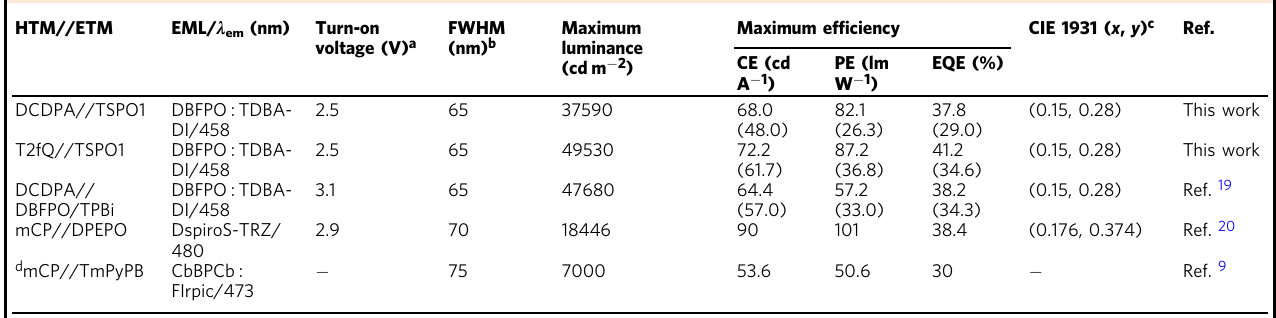
Table 1 Summary of the performance characteristics of our best-performing blue OLEDs and comparison with the best- performing, to date, blue TADF OLEDs 19,20 and blue PHOLED 9